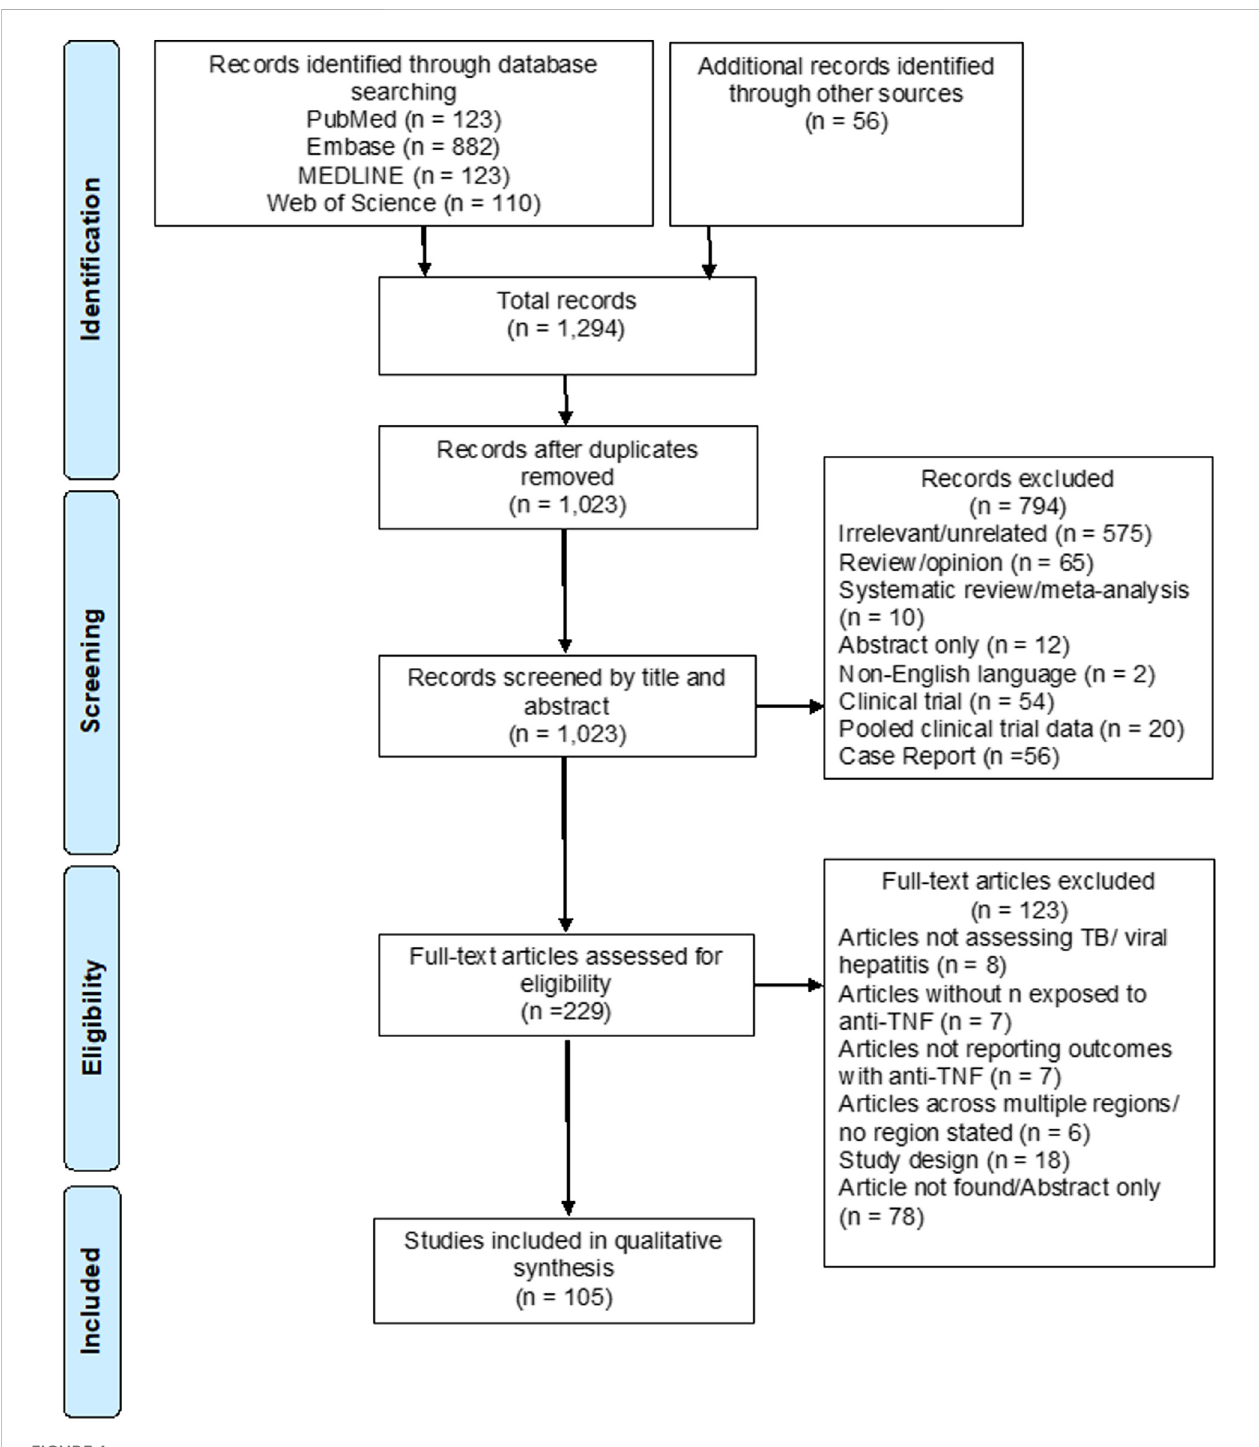
FIGURE 1 PRISMA fl ow diagram of study identi fi cation, screening, and selection for inclusion in this systematic review.